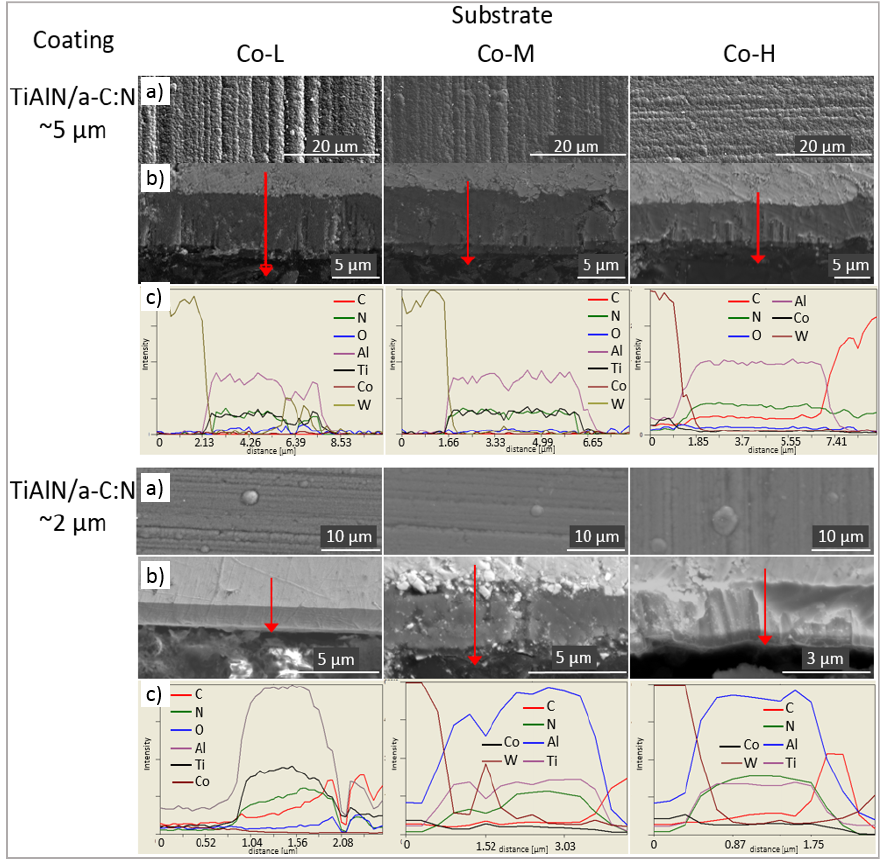
Figure 6. Morphology ( a ), metallographic cross-section SEM images ( b ) and EDX line scan compo- sition profiles ( c ) of TiAlN/a-C:N double layer coatings deposited on Co-L, Co-M and Co-H sub- strates.